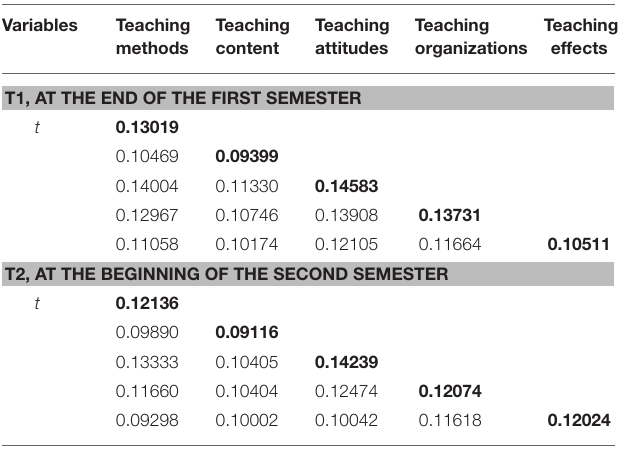
TABLE 4 | Variance and covariate components from G study, effect of evaluation time